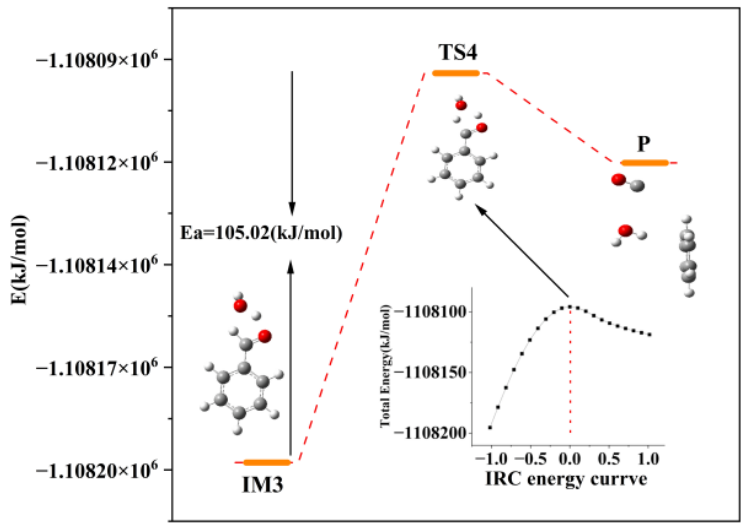
Figure 5. Activation energy of CO formed by the methyl group.